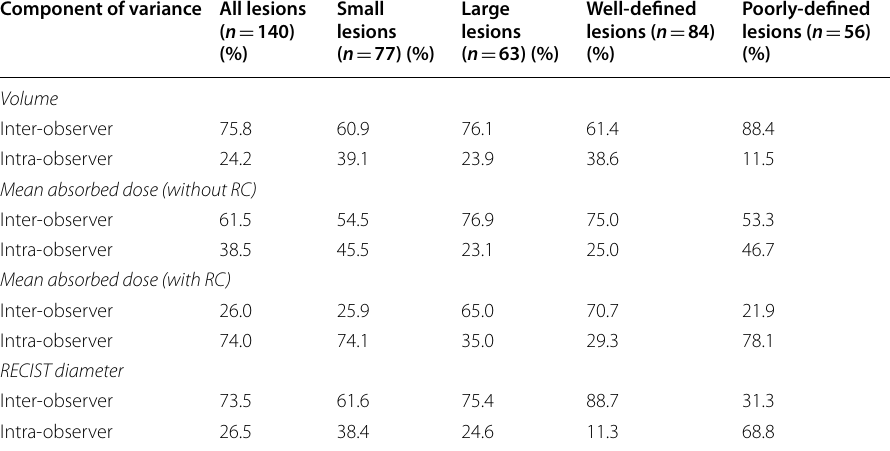
Table 2 Percentage of variance attributable to inter- and intra-observer differences for volume, mean absorbed dose, and RECIST diameter measurements in all lesions and covariate-defined subgroups after accounting for inherent variability due to the lesions Component of variance All lesions